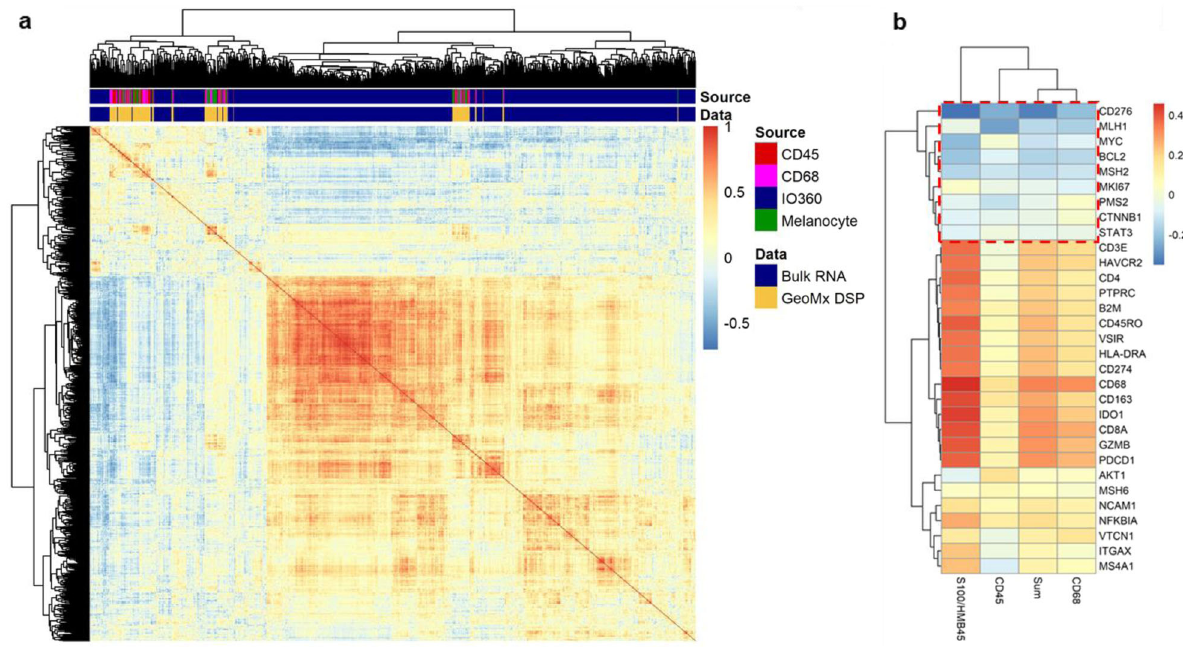
Fig. 1 Correlation between mRNA and protein. a Unsupervised hierarchical cluster analysis for 770 mRNA targets acquired using NanoString nCounter ® PanCancer IO 360 ™ panel and 44 protein targets acquired in three different compartments (s100/HMB45, CD45, and CD68) using NanoString GeoMx ® Digital Spatial Pro fi ler (DSP). DSP data generally cluster separately from bulk RNA pro fi ling data. b Heatmap showing Spearman ranked correlation coef fi cient between bulk RNA and corresponding proteins quanti fi ed in three different compartments and the sum of all three compartments. A subset of protein targets shows weak correlation or anti-correlation to their precursor mRNAs (red dashed box).